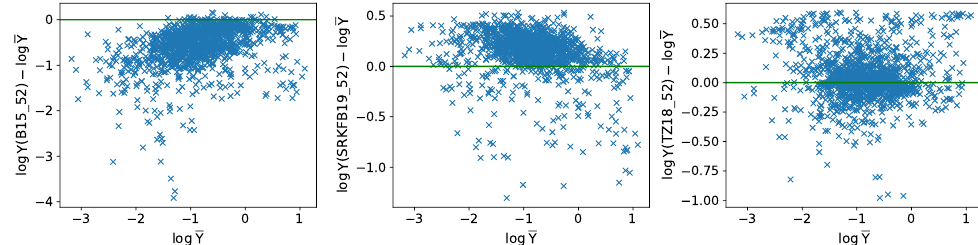
Figure 15. [Fe II ] ECS logarithmic differences at T = 10 4 K for each transition in the coll datasets B15_52, SRKFB19_52, and TZ18_52 relative to the average